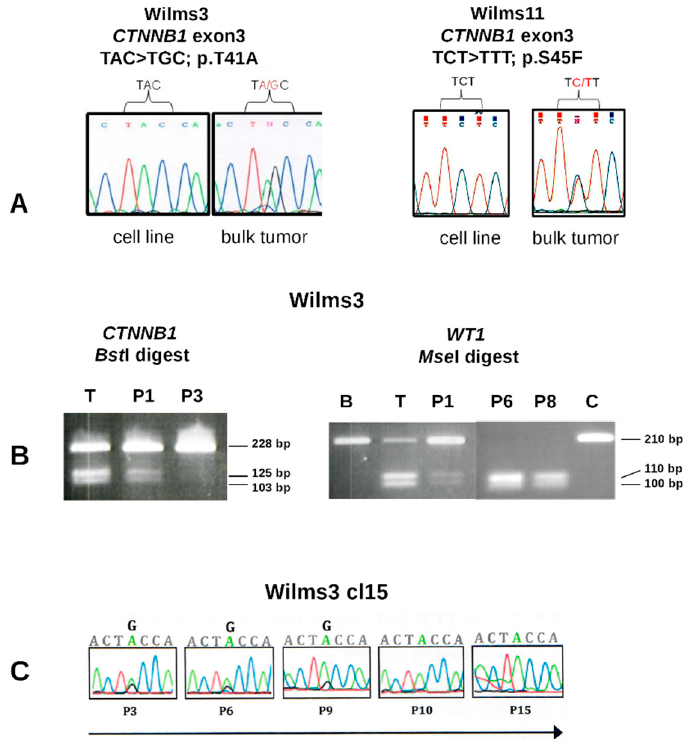
Figure 2. WT1 and CTNNB1 sequence analysis Wilms3 and Wilms11 DNA. ( A ) Partial sequence of CTNNB1 exon3 from cell lines and bulk tumor DNA from patient Wilms3 (left) and Wilms11 (right) with the mutations indicated. ( B ) Restriction enzyme digest of PCR products with Bst I, recognizing only the mutant CTNNB1 exon3 DNA (left) and Mse I recognizing only the mutant WT1 exon10 (right). T: bulk tumor DNA; B: blood DNA, P1, P3, P6 and P8 correspond to DNA isolated from cell culture in MSC medium at the respective passage number, C = control DNA. ( C ) DNA isolated from Wilms3 cl15 cells was sequenced and the CTNNB1 mutation is gradually lost and at passage 10 not present anymore.